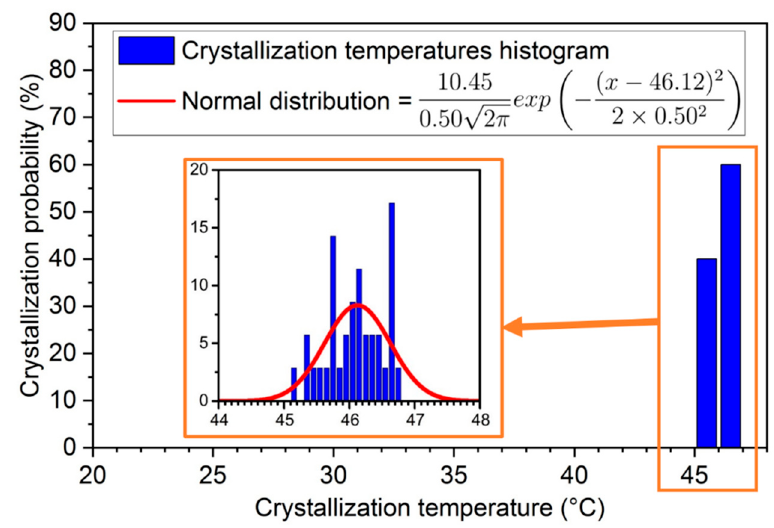
Figure 14. Probability distribution of crystallization temperatures for SAT58%. In the inset, the crystallization temperature has a 0.1 °C temperature step.